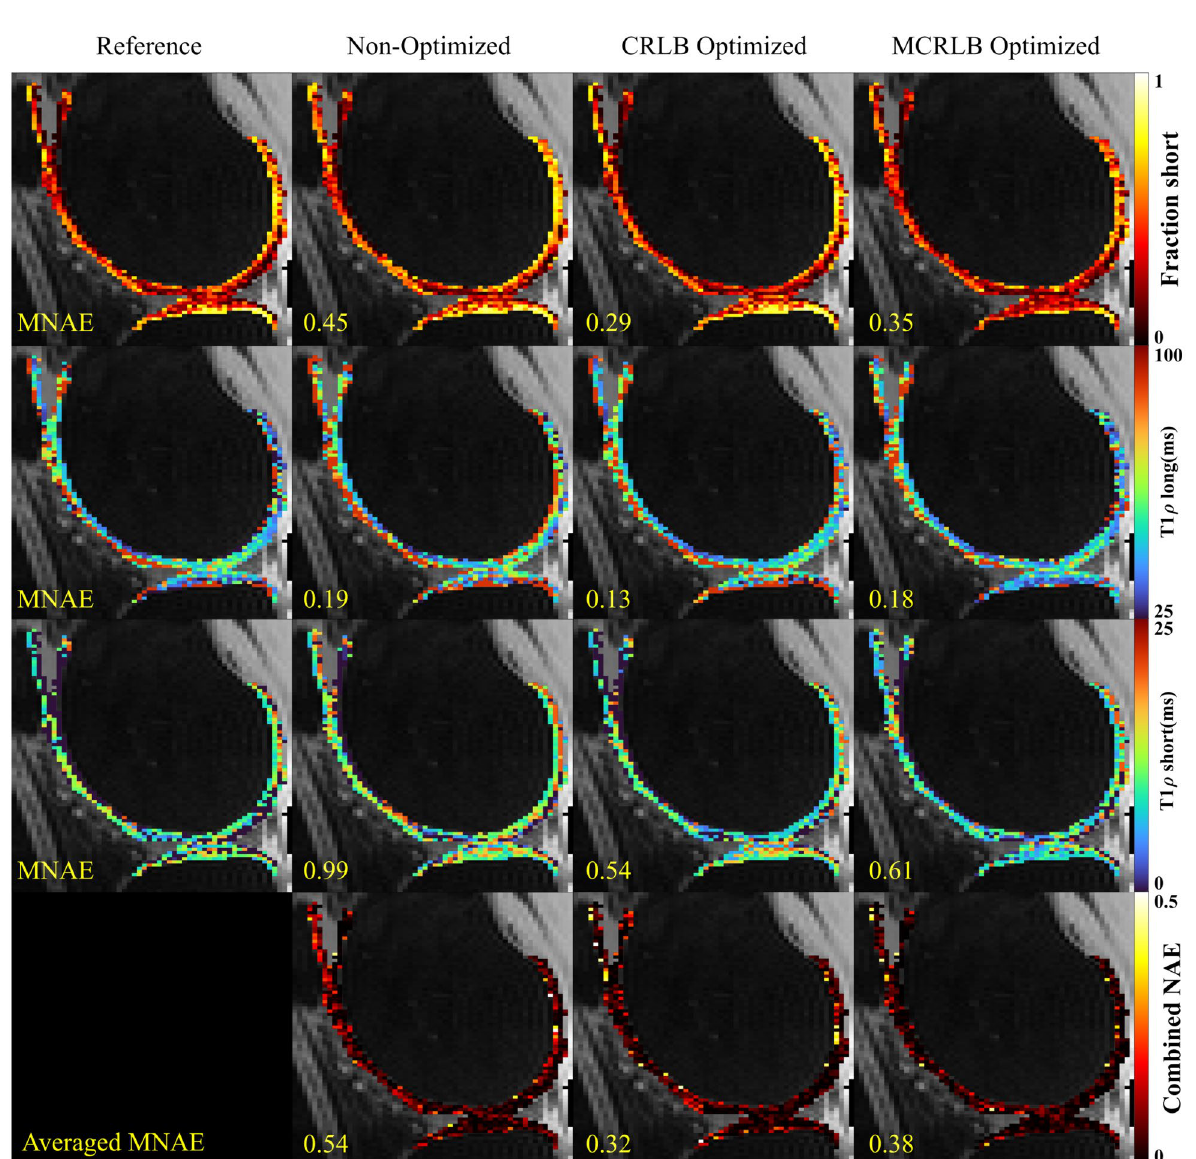
Figure 5. Parameter maps for the bi-exponential model fitted using the three different sampling schedules on the first volunteer dataset. The combined NAE uses the weighting vector used in the optimization to average the voxel-wise over different parameters. Image created using Matlab 27 and Inkscape 28